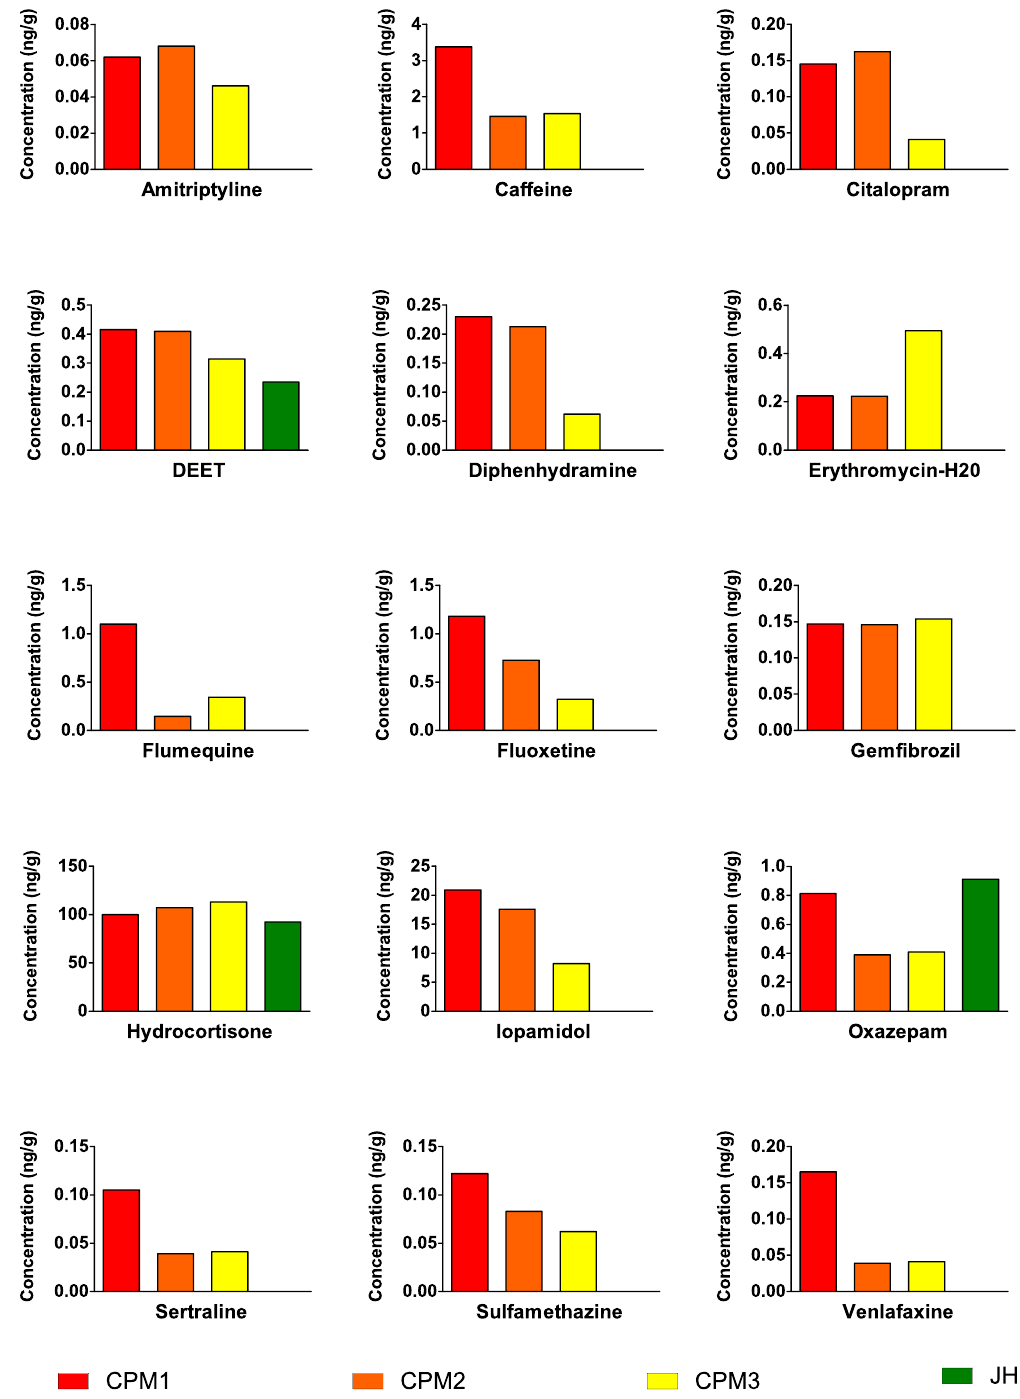
Figure 4. Pharmaceuticals detected in plasma of male caged goldfish after 21 days of deployment in Cootes Paradise Marsh (CPM1, CPM2, and CPM3) and the reference site, Jordan Harbour (JH) (each bar represents a single value from pooled plasma of 25 goldfish). Data presented in this figure are adapted from the companion manuscript by Muir et al . 17